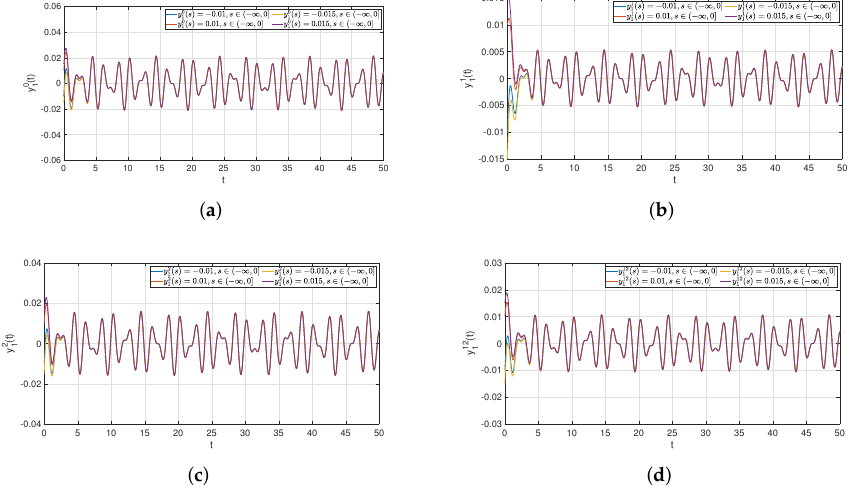
( t ) , y 1 ( t ) , y 2 ( t ) , y 12 ( t ) of system (5) with different initial values. ( a ) y 0 1 1 1 1 with different initial values; ( c ) y 2 1